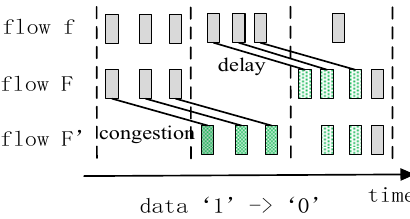
Figure 1. An example of the distortion of IBF.